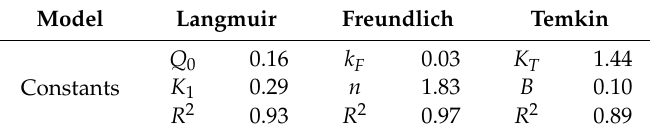
Table 3. Isotherm model constants for ferric ion adsorption onto celestite surface ( T = 298 K). Model